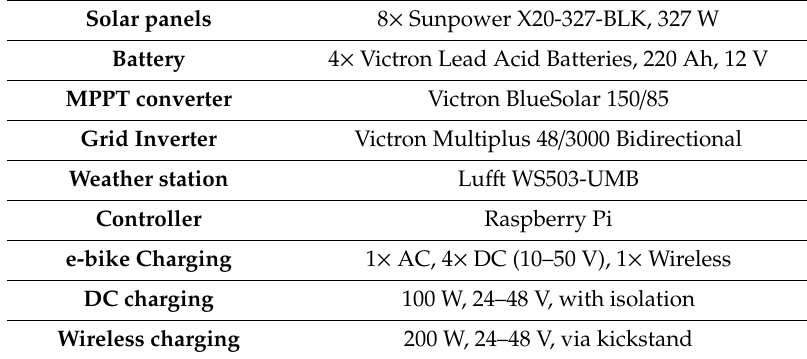
Figure 3. Schematic of the solar e-bike station with 48 V DC interconnection that facilities power exchange between the solar panels, e-bike chargers, and the AC grid. Table 1. Specifications of the solar e-bike charging Table 2. Specifications of the E-bike and E-scooter.